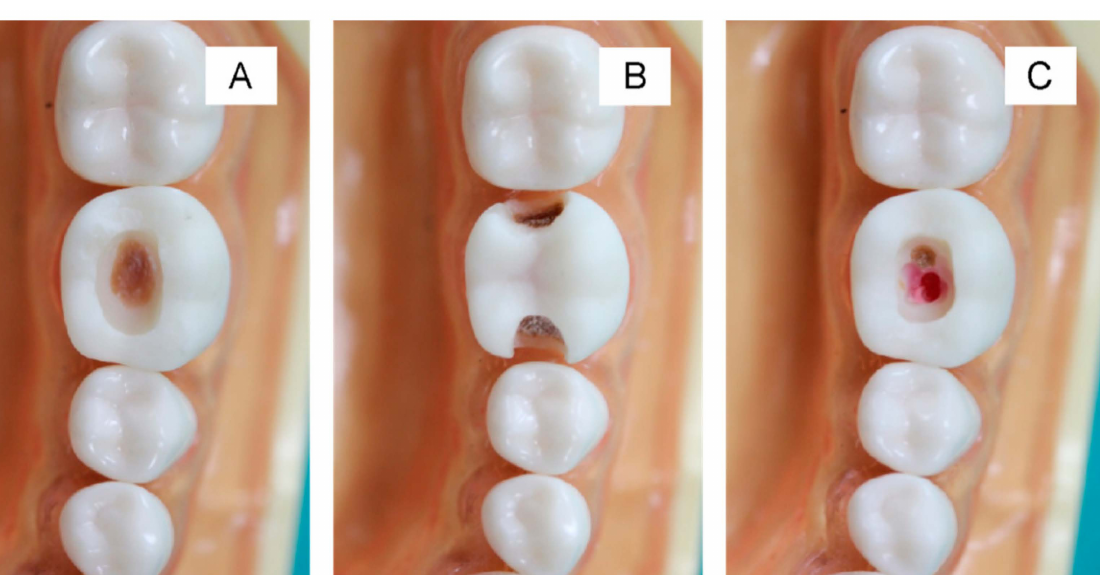
Figure 6. Example of the task completed after cavity preparation. Class I ( A ) and II ( B ) with remaining caries over the pulp to prevent pulp exposure. The peripheral margin of the prepared cavity was in the sound tooth structure. Excessive wax appeared when the preparation was too deep ( C ).